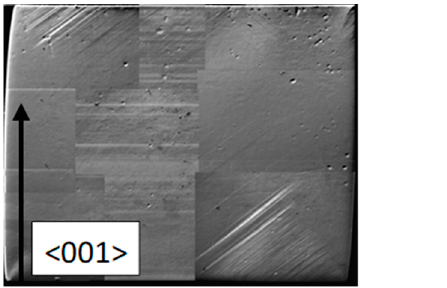
Figure 16. Deformation patterns on {100} lateral faces of a < 001 > Ni single crystal with h / d = 1; ε = 13%.